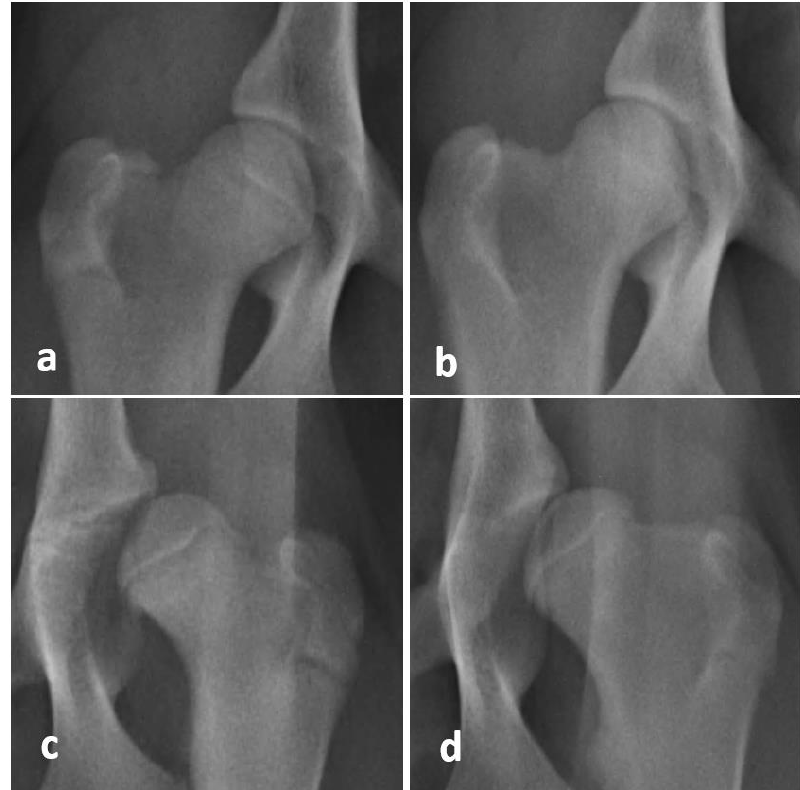
Figure 1. Magnification of an extended ventrodorsal view of the right and left hip joints of two Rottweilers: ( a ) A dog at the age of 31 weeks, and ( b ) the same dog at the age of 52 weeks. The joint was consistently graded as HD A for this dog. ( c ) Another dog at the age of 18 weeks, and ( d ) the same dog at the age of 30 weeks. The joint was consistently graded as HD E and unsurprisingly, did not improve with continuous age.